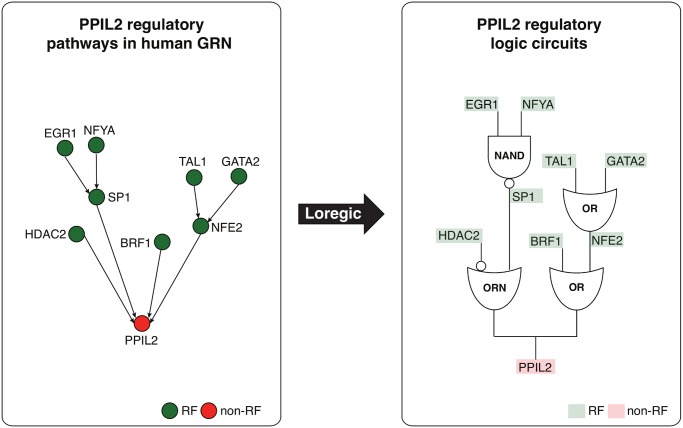
Depiction of two logic circuit regulatory pathways targeting PPIL2.Two logic circuit regulatory pathways targeting the PPIL2 gene, an important cyclophilin member in immunological suppression, are found by Loregic: 1: PPIL2 is co-regulated by HDAC2 and SP1 forming the triplet of (RF1 is HDAC2, RF2 is SP1, T is PPIL2), which is consistent with the “T = ~RF1+RF2” gate (the ORN gate[22]), and SP1 is co-regulated by EGR1 and NFYA forming the triplet of (RF1 is EGR1, RF2 is NFYA, T is SP1), which is consistent with the “T = ~RF1*~RF2 (the NAND gate); 2: PPIL2 is also co-regulated by BRF1 and NFE2 forming the triplet of (RF1 is BRF1, RF2 is NFE2, T is PPIL2), which is consistent with OR gate, and NFE2 is co-regulated by TAL1 and GATA2 forming the triplet of (RF1 is TAL1, RF2 is GATA2, T is NFE2), which is also consistent with OR gate. We replace the triplets on these pathways using matched logic gates, and depict the pathways using logic circuits to summarize the regulatory logics targeting PPIL2 at the pathway level.